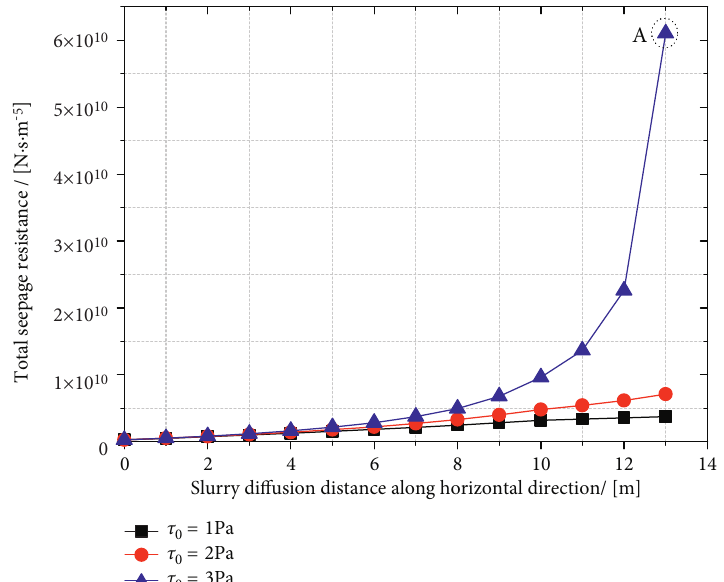
Figure 4: Relationship between the total seepage resistance of the system and the water-displacing diffusion distance of slurry (different yield stress values).